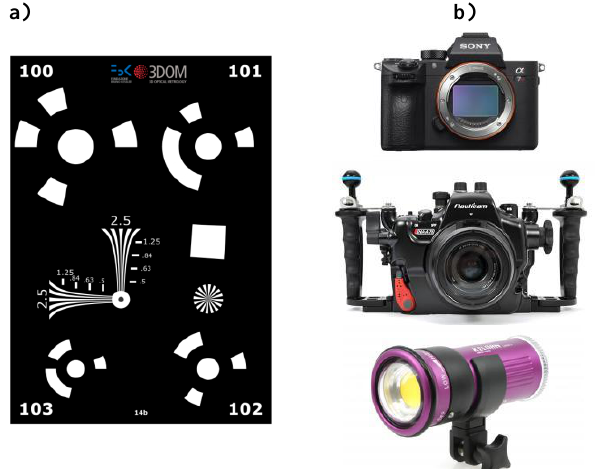
Figure 1. Portable A5 target made in rigid Dibond aluminum with known distances and resolution targets used since 2018 for underwater photogrammetry campaigns in Antarctica (a). New camera system used from 2018 (Sony A7sII-16mm, Sony Vario- Tessar T* FE 16-35mm F4) in a dedicated Nauticam housing with dome port mounting and led video light Keldan 4X Compact (10000 lumen)